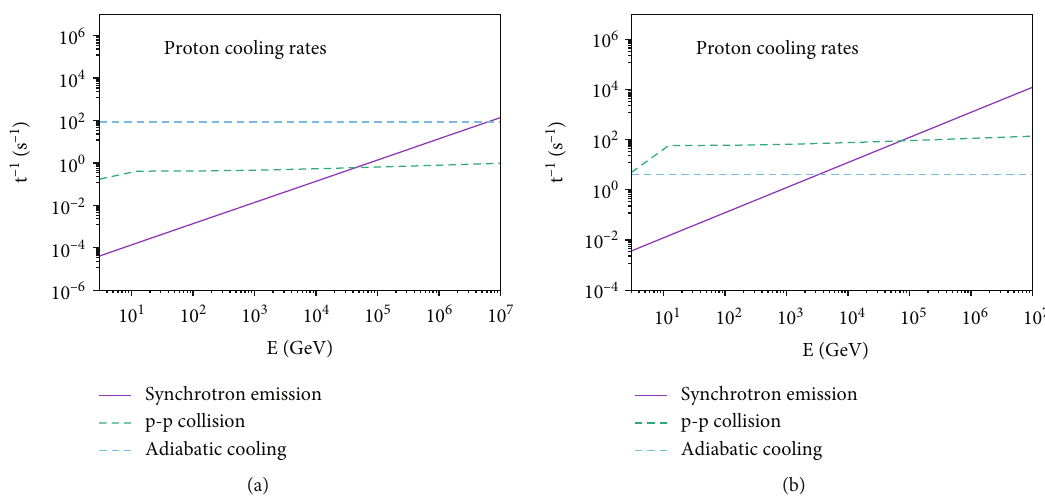
. The plots of cooling rates show the 0